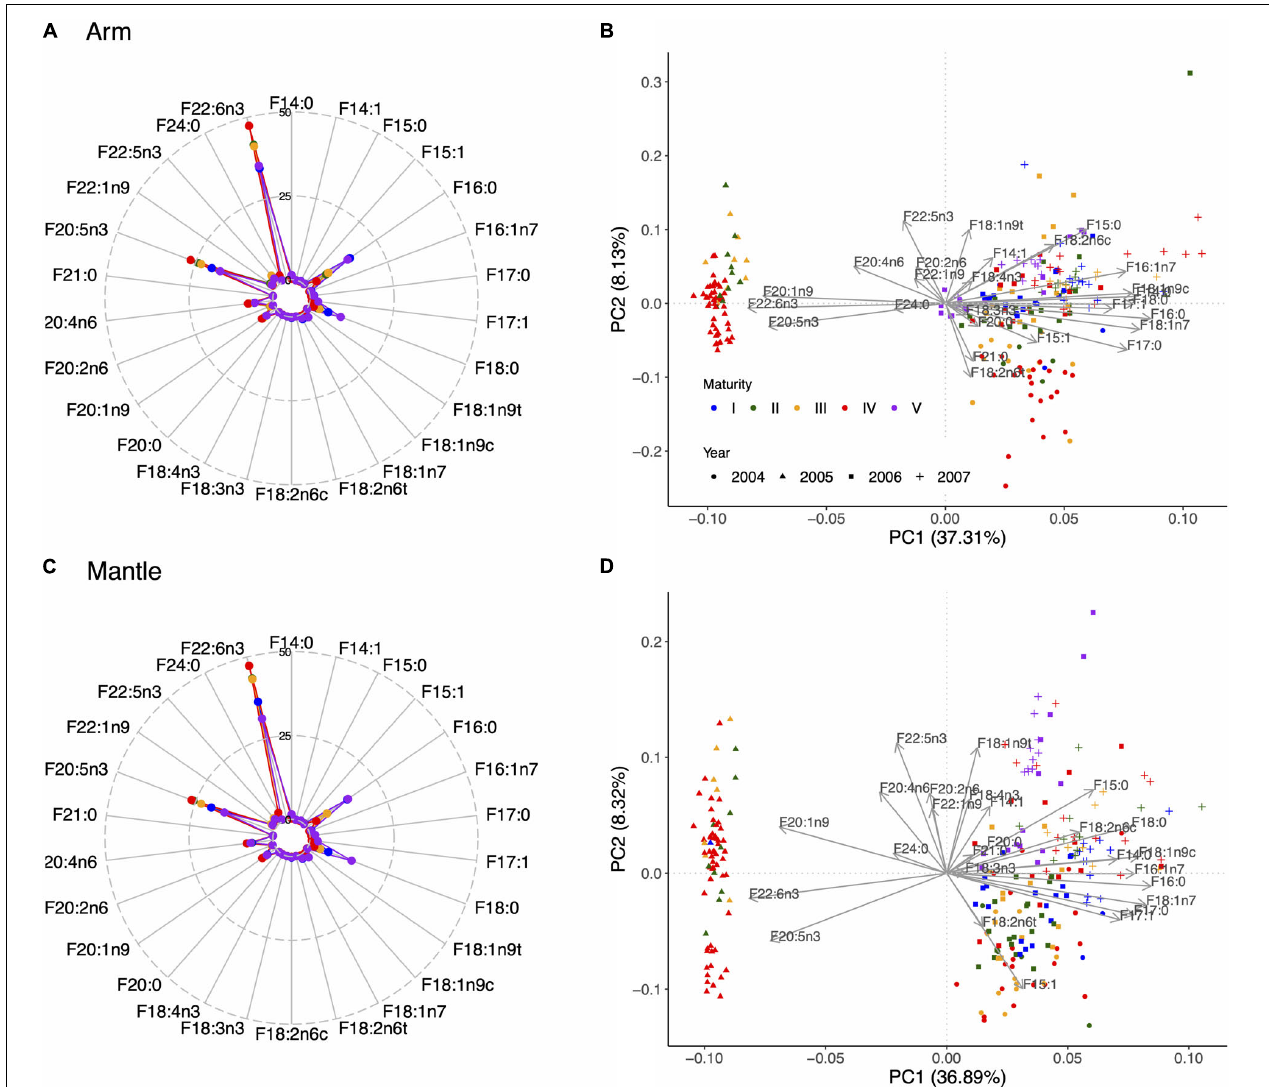
FIGURE 5 | Radar plots showing the percentage of each of the analyzed fatty acids (FA) across maturity stages in the arm (A) and mantle (C) . (B,D) Illustrate the principal component analyses in the arm and mantle, respectively, showing the contribution of each analyzed FA across maturity stages and sampled